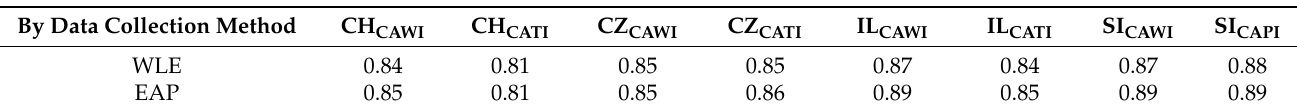
Table 6. WLE and EAP reliability coefficients separately for data collection method for respective countries.